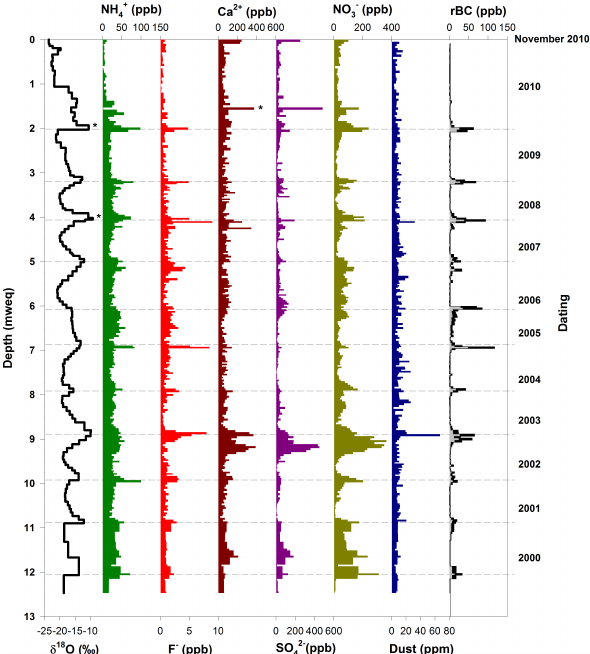
Figure 2. Firn core profiles with depth for water stable isotope ( δ 18 O), ammonium, fluoride, calcium, sulfate, nitrate, dust and re- fractory black carbon ( M rBC in gray and rBC in black) on Mera Glacier. The scale on the right vertical axis corresponds to the an- nual dry season. The stars correspond to the observed ice